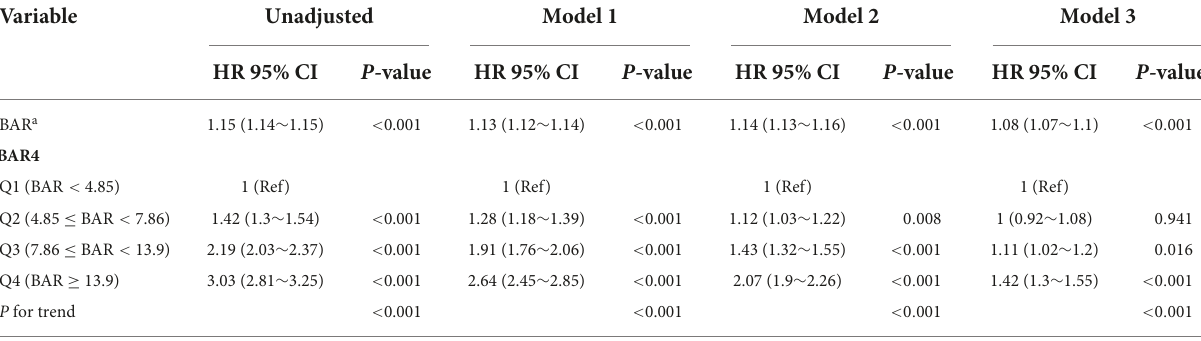
TABLE 2 Multivariable Cox regression analysis to assess the association between BAR and in-hospital mortality. Variable